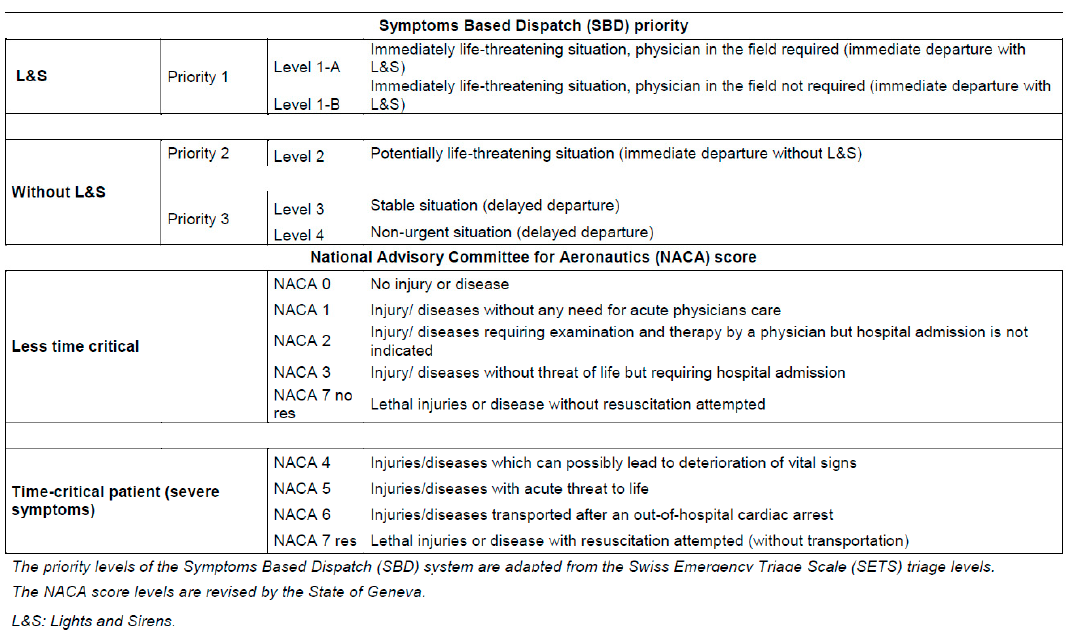
Figure 2. Definition of the dispatch priority levels and the NACA score levels on the field.